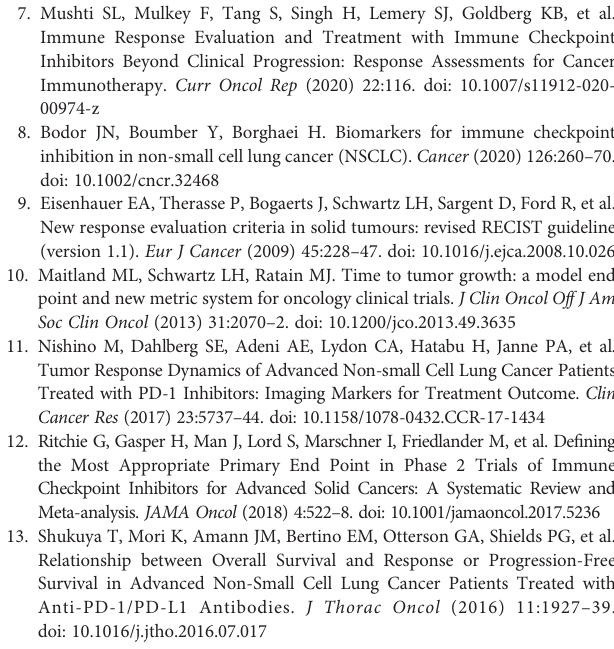
SUPPLEMENTARY FIGURE 1 | Kaplan-Meier analysis of overall survival by pre- treatment tumor growth